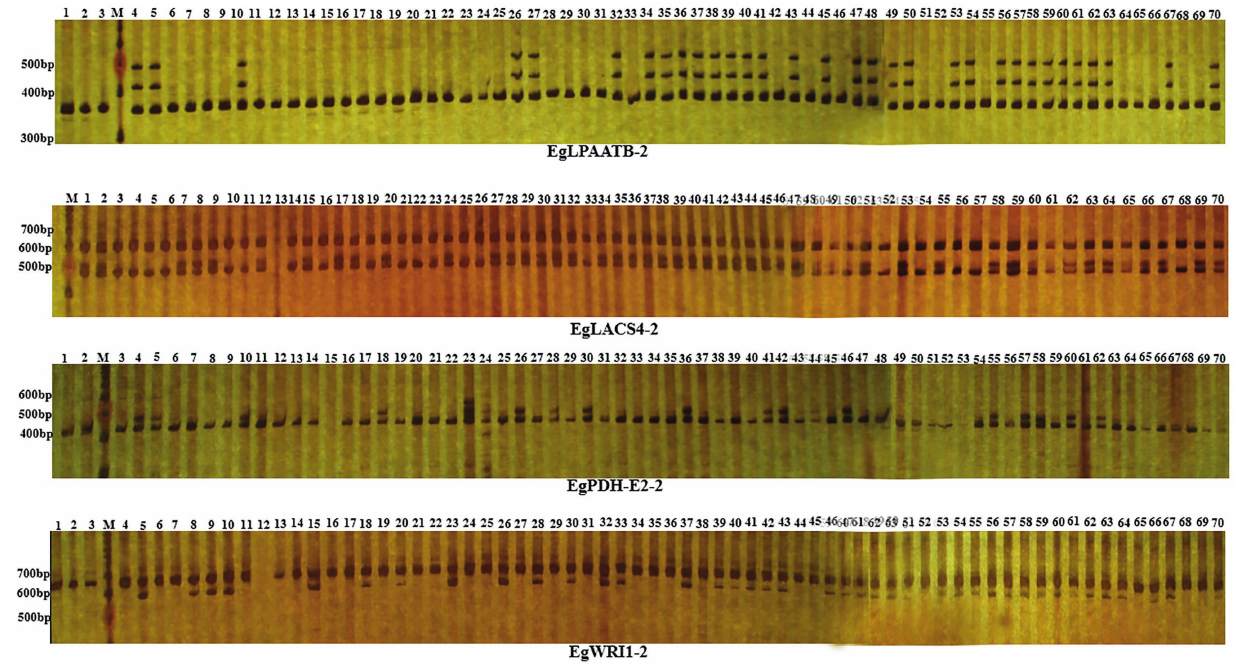
FIGURE 3 | PCR products of IP marker EgLPAATB-2, EgLACS4-2, EgPDH-E2-2 and EgWRI1-2 in 70 oil palm samlpes separated by electrophoresis on 6% non- denaturing PAGE. Lanes 1–70 represent the 70 oil palm samples. M represents 100 bp ladder.